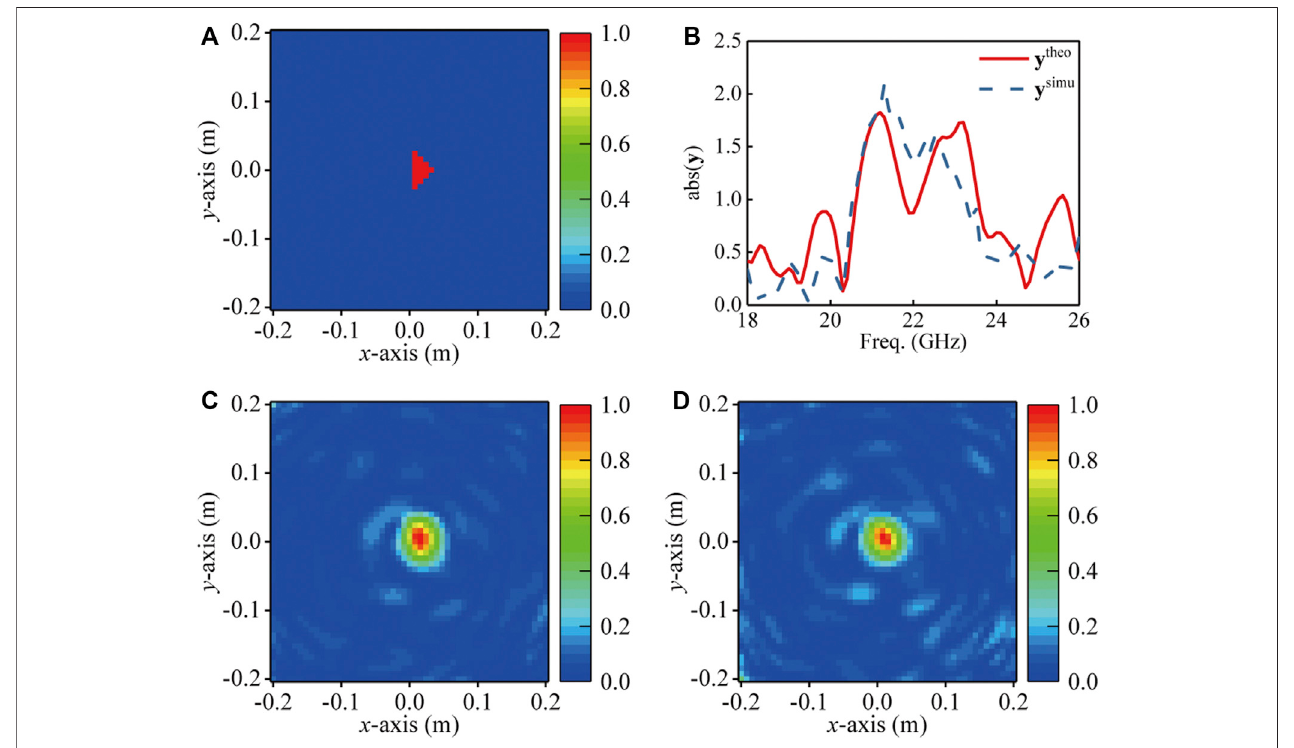
FIGURE 5 | (A) Triangle PEC object. (B) Comparison of the calculated y theo and simulated y simu . (C) The reconstructed imaging x theo using y theo . (D) The reconstructed imaging x simu using y simu .